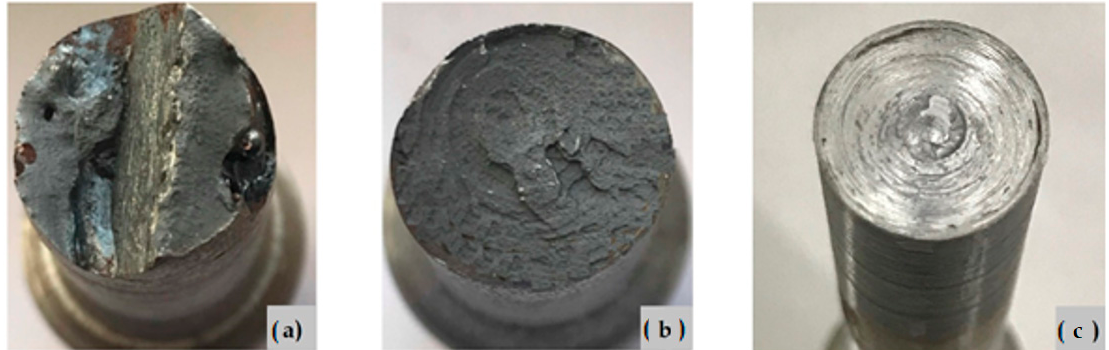
Figure 7. Cross-sectional view of broken specimens using tensile testing: ( a ) Broken electric arc welded specimen, ( b ) friction welded broken steel specimen and ( c ) broken aluminum specimen.